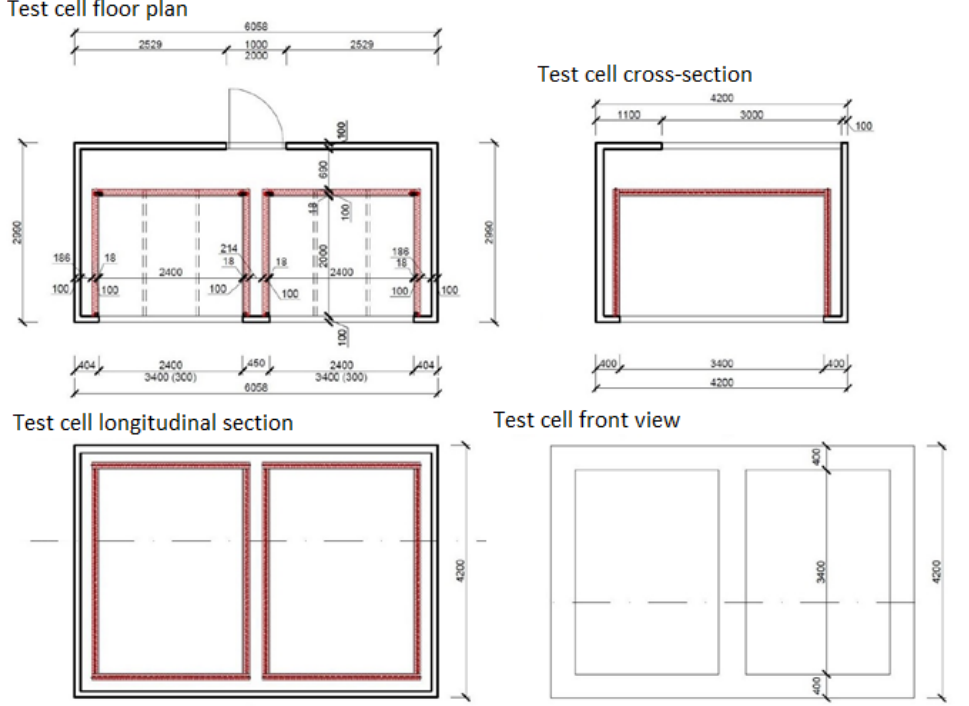
Figure 1. Construction schemes of an experimental test cells Twin Rooms for testing advanced facade elements in real conditions of outdoor